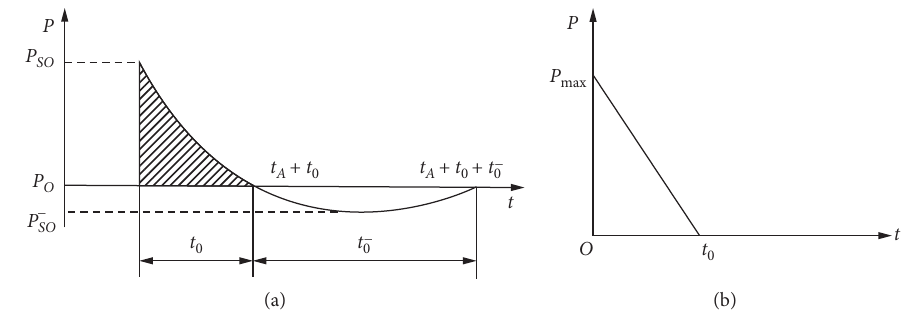
Figure 6: Press-time curve of blast loading. (a) Typical blast loading. (b) Simplified blast